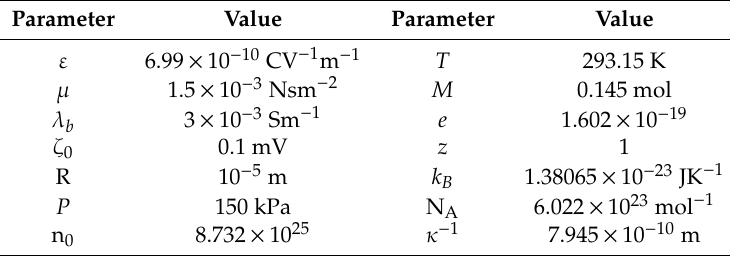
Table 1. Parameters used in the